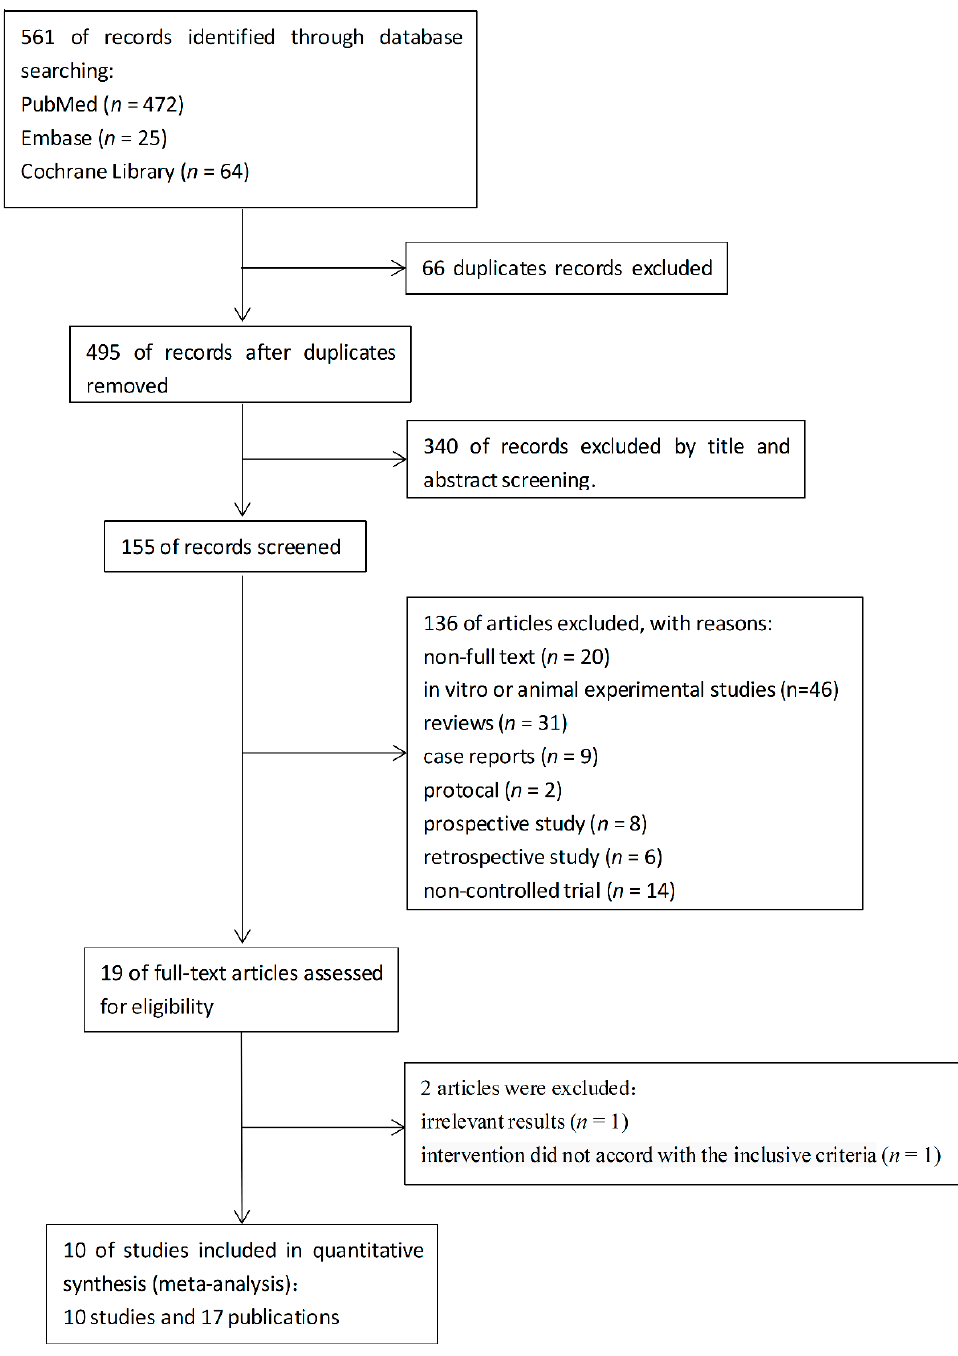
Figure 1. Flow diagram of the literature search process.